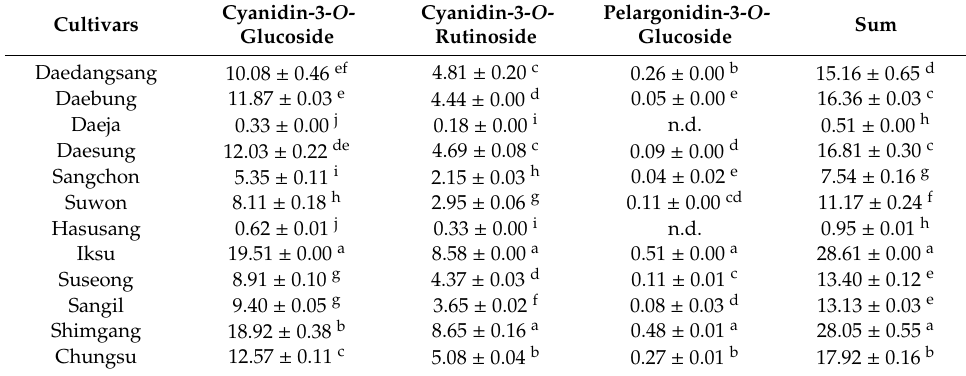
Table 3. Anthocyanin contents (mg / g DW) in 12 mulberries cultivar determined by high-performance liquid